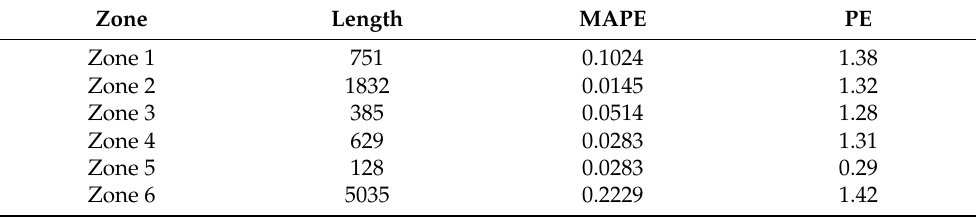
Table 5. MAPE values and PE of each zone.